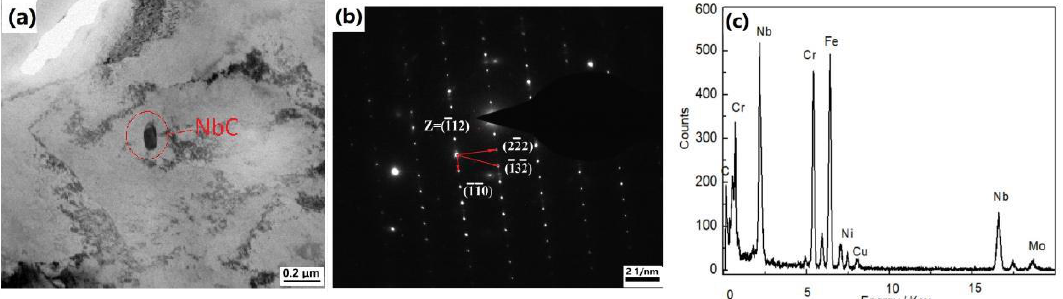
rate of 1 s − 1 . Precipitates appear inside the grain in Figure 13a. Combined with EDS, the di ff raction spot was designated as NbC, which was not greater than 200 nm in length.